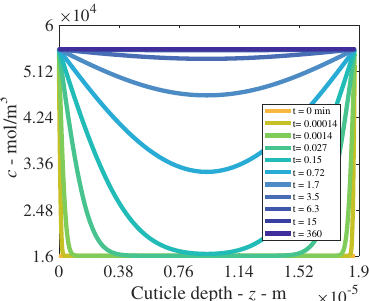
Fig. 3 Plant cuticle model results at a single relative humidity of 60%RH, for the concentration of diffusing water molecules over 6 h. Over the depth of the cuticle, results are shown at a selection of times. The initial condition is shown in orange and the boundary conditions for the outside and inside cuticle surfaces are located at cuticle depth 0 and 1.87 × 10 − 5 m, shows the results of the model (green dots), compared to the